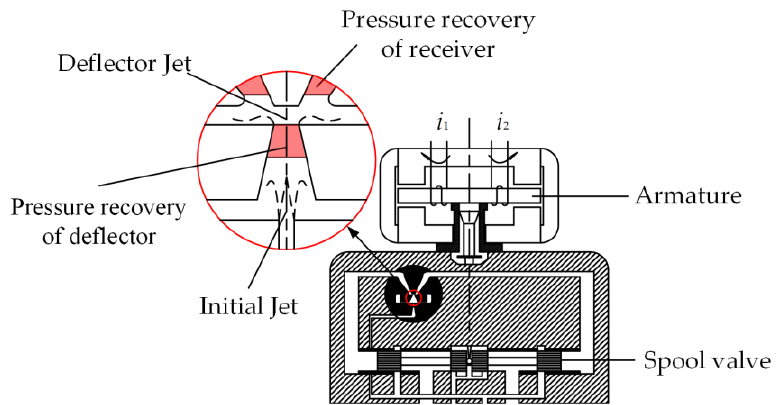
Figure 1. Stages of flow in hydraulic amplifier of DJV.